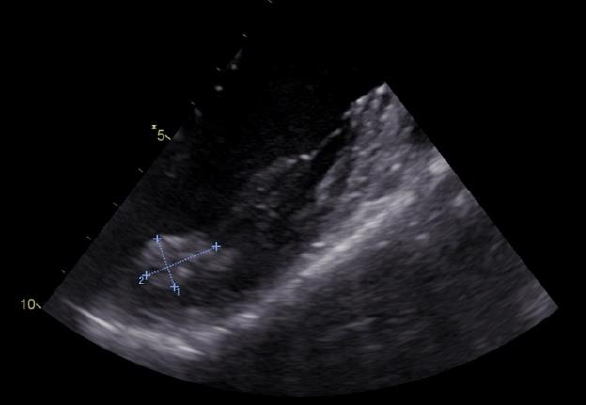
Figure 1. Two-dimensional transesophageal echocardiography of the tumour in the left ventricle and papillary muscle at the base of the anterolateral papillary muscle (orange arrow, tumour; blue arrow, green arrow, anterolateral papillary muscle) .